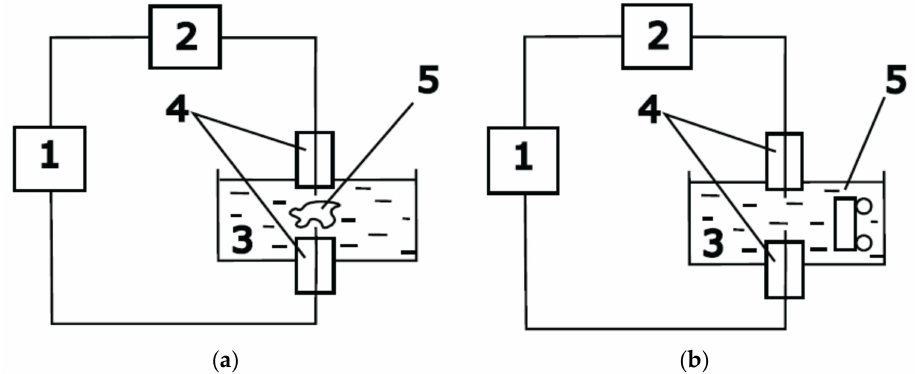
Figure 1. Schemes of ( a ) electropulse and ( b ) electrohydraulic technologies; presented in the pa- per [36]: 1—high-voltage pulse generator, 2—switchboard, 3—discharge chamber filled with liquid, 4—electrode system, 5—technology specimen. Adapted with permission from Ref. [36]. Copyright 2019, Publishing House of the Ural